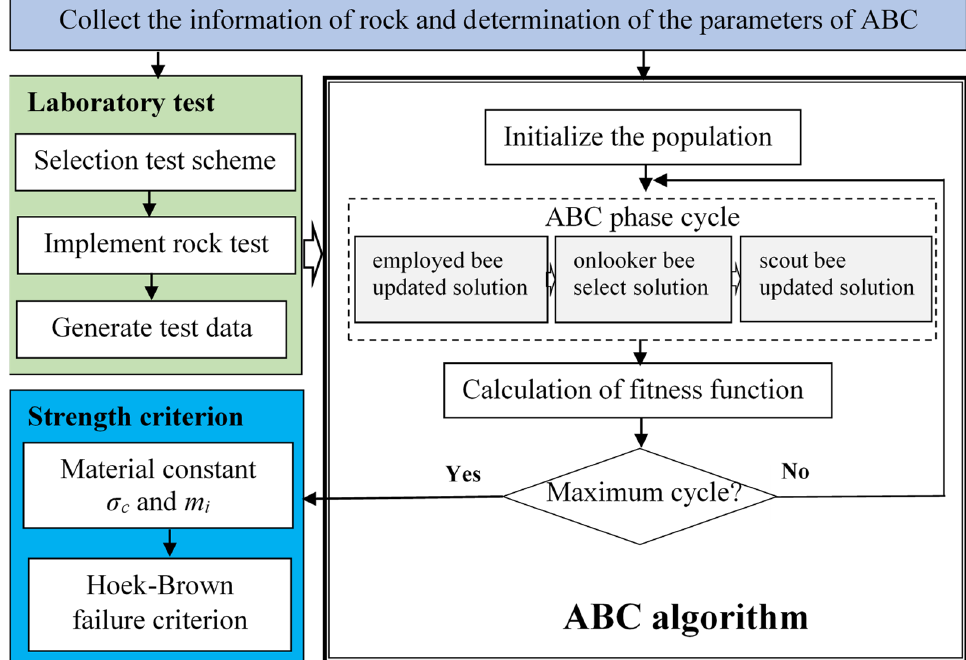
Figure 3. The ABC-based approach for determination of Hoek-Brown failure criterion.